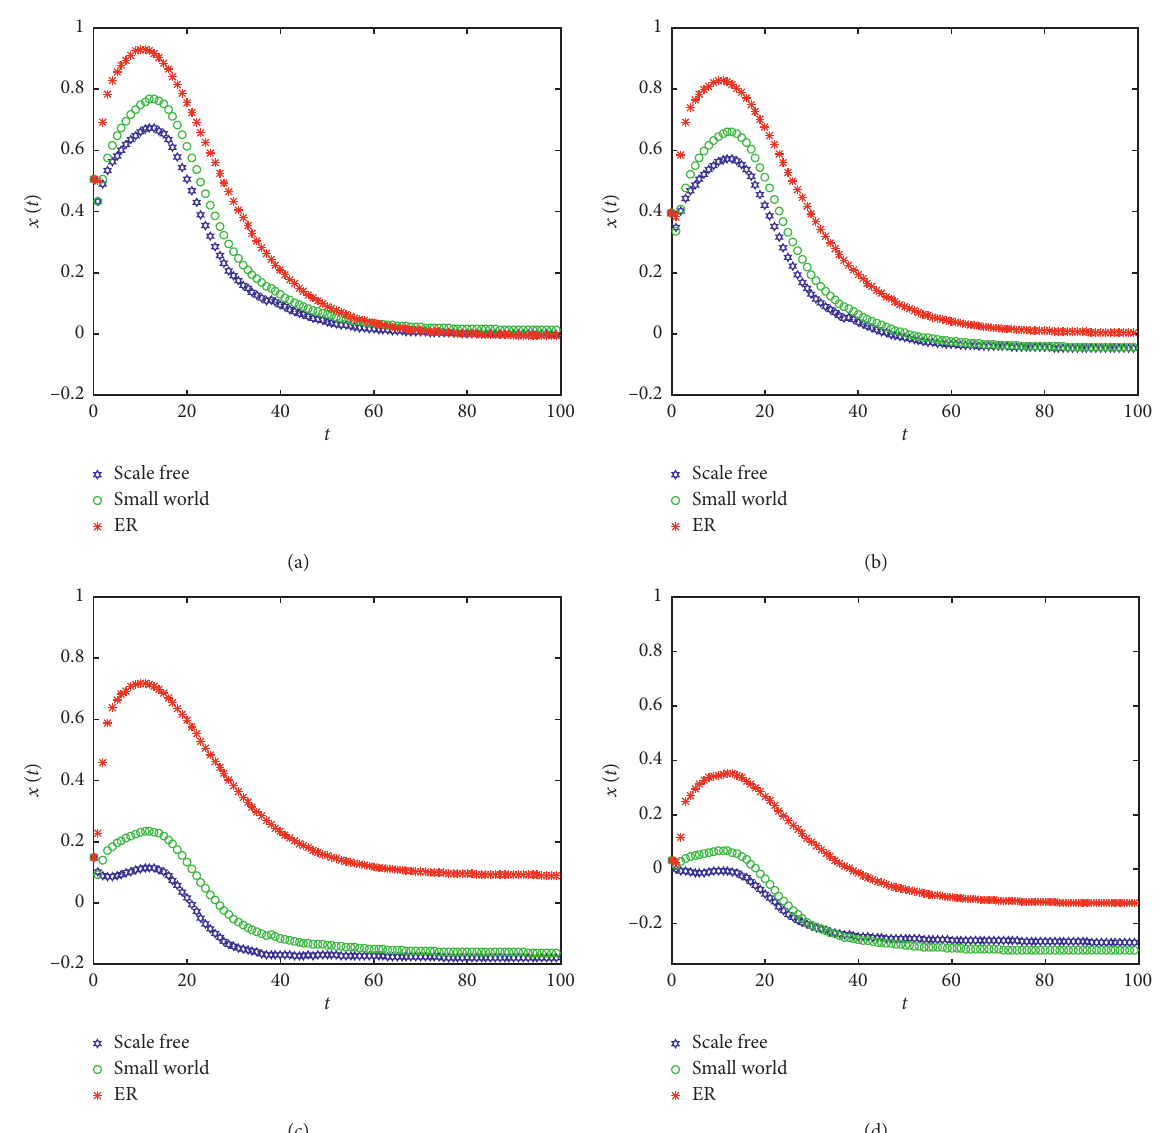
Figure 12: Evolution of average collective opinions under three topologies: (a) P P n � 5%; (c) P s � 70%, P o � 25%, and P n � 5%; (d) P s � 50%, P o � 45%, and P n �